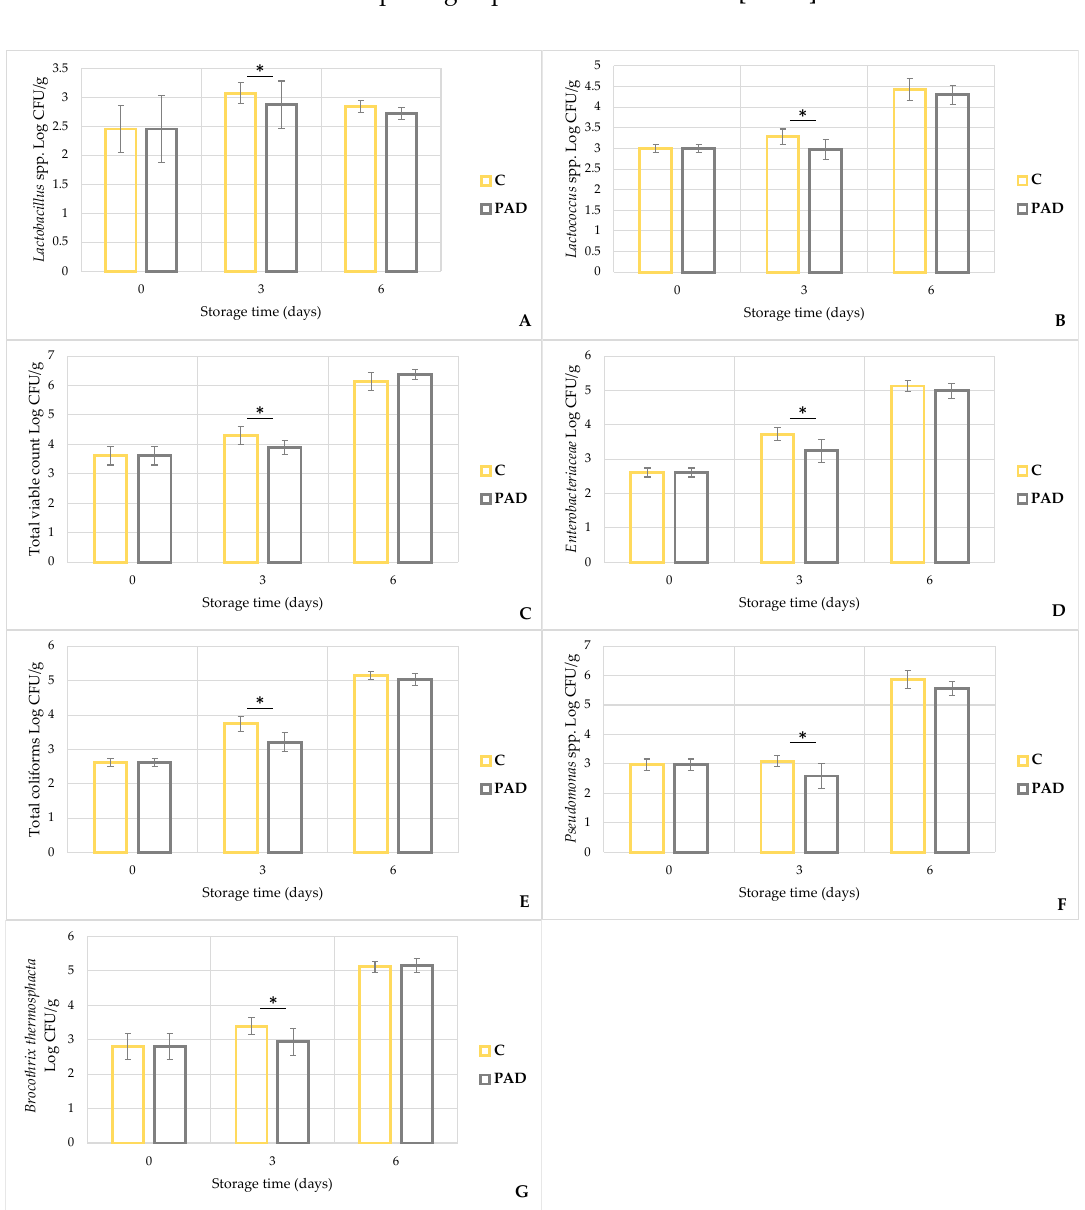
Figure 3. Trend of microbial development during storage in control (C) and PAD group. Lactobacillus spp. ( A ), Lactococcus spp. ( B ), total viable count ( C ), Enterobacteriaceae ( D ), total coliforms ( E ), Pseudomonas spp. ( F ) and Brocotrhix thermosphacta ( G ). The bar graphs show mean ± standard deviation. *: p < 0.05.